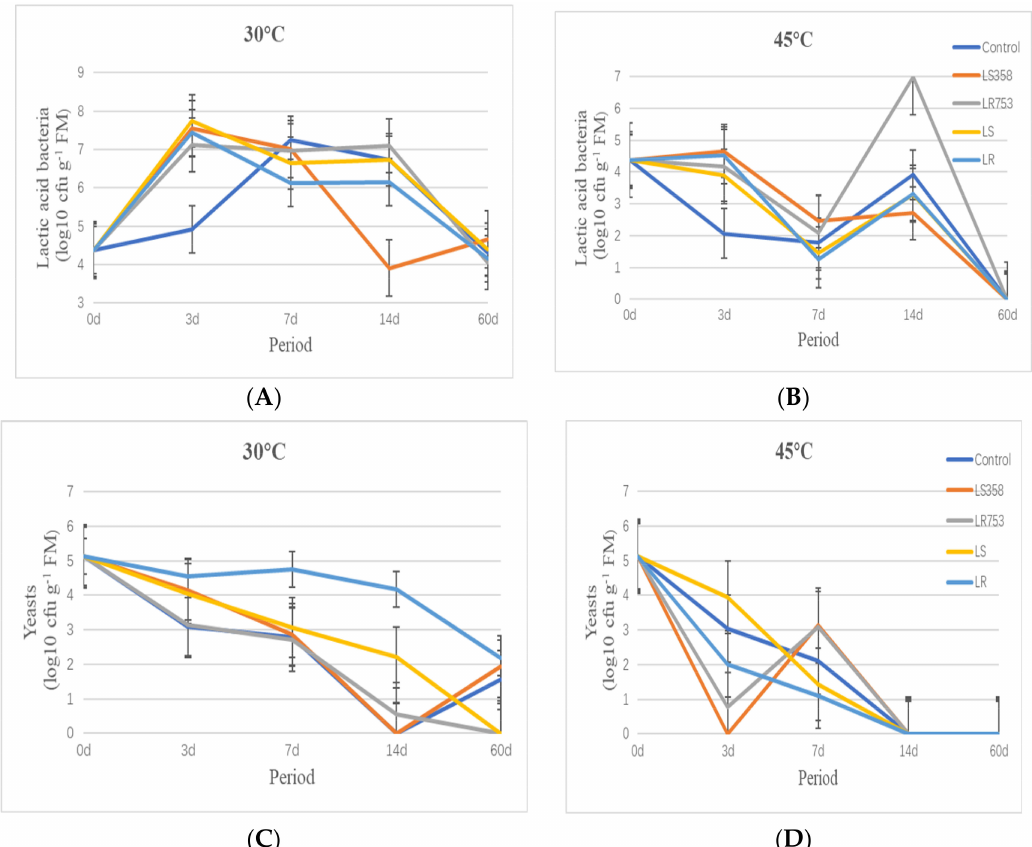
Figure 1. Dynamic microbial counts of corn silage prepared with two temperatures at di ff erent ensiling period. ( A ) Dynamic counts of lactic acid bacteria at 30 ◦ C; ( B ) Dynamic counts of lactic acid bacteria at 45 ◦ C; ( C ) Dynamic counts of yeast at 30 ◦ C; ( D ) Dynamic counts of yeast at 45 ◦ C. Note: LS358 = Lactobacillus salivarius 358; LR753 = Lactobacillus rhamnosus 753; LS = Lactobacillus salivarius ATCC 11741; LR = Lactobacillus rhamnosus ATCC